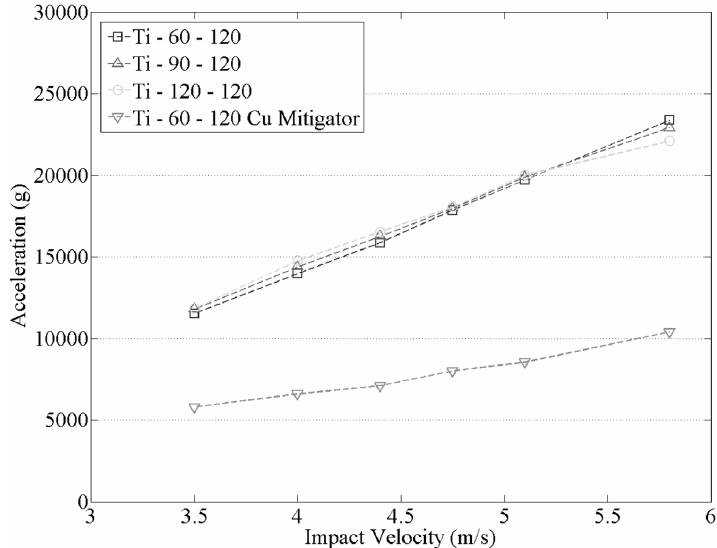
Fig. 8. Maximum acceleration plotted against impact velocity for a range of test rods and pulse shaping mechanisms. The broken lines between data points represent an indicative